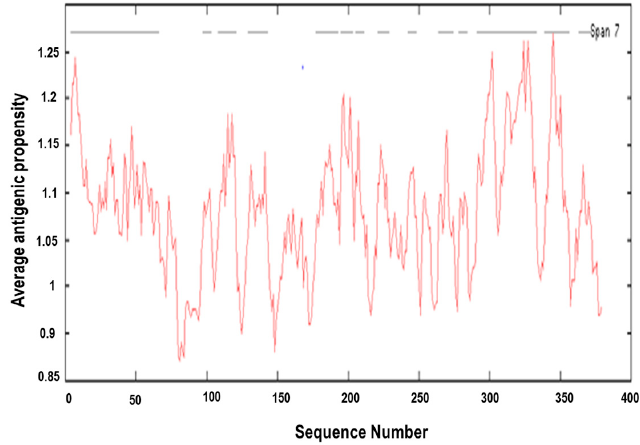
Figure 6. Antigenic plot of MMIC-A. The predicted peptides with potential antigenic properties depicting the start and end positions within the MIC-A sequence are shown.